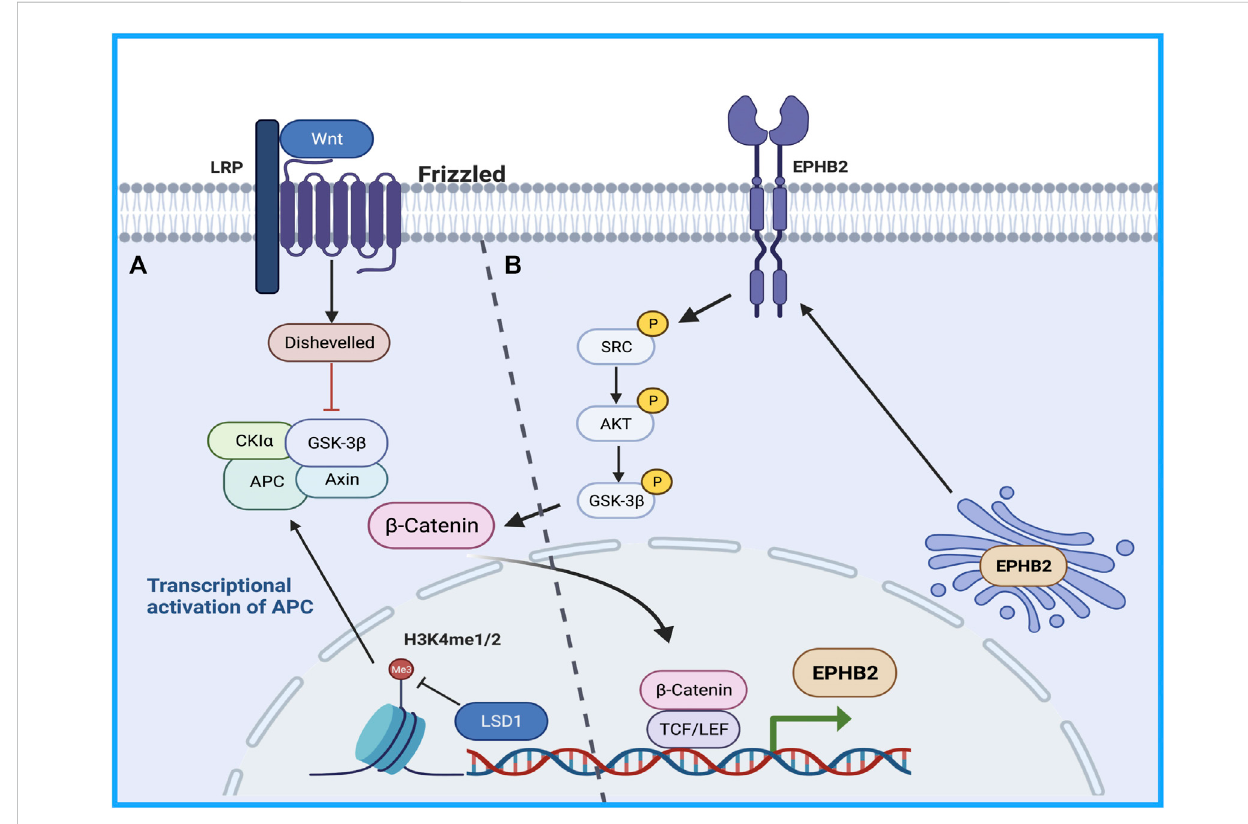
FIGURE 1 The Wnt/ β -catenin pathway regulates stem cell proliferation and differentiation. (A) LSD1 is able to demethylate the monomethyl and dimethyl residuesoflysine-4onhistoneH3,therebyinhibitingtheexpressionofseveralsuppressorsof β -cateninsignalingpromoting β -cateninactivation,thereby promoting self-renewal and drug resistance in CSCs. (B) TCF1/EPHB2/ β -catenin positive feedback loop regulates cancer stemness and drug